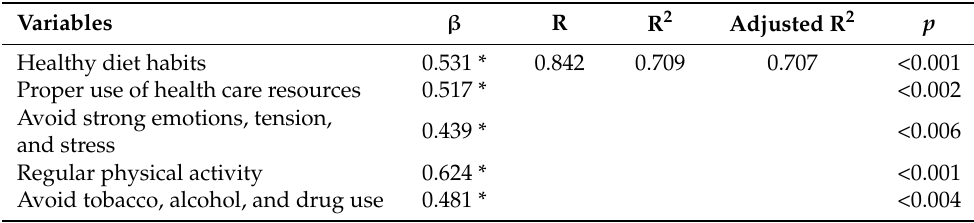
Table 9. Multiple linear regression analysis of